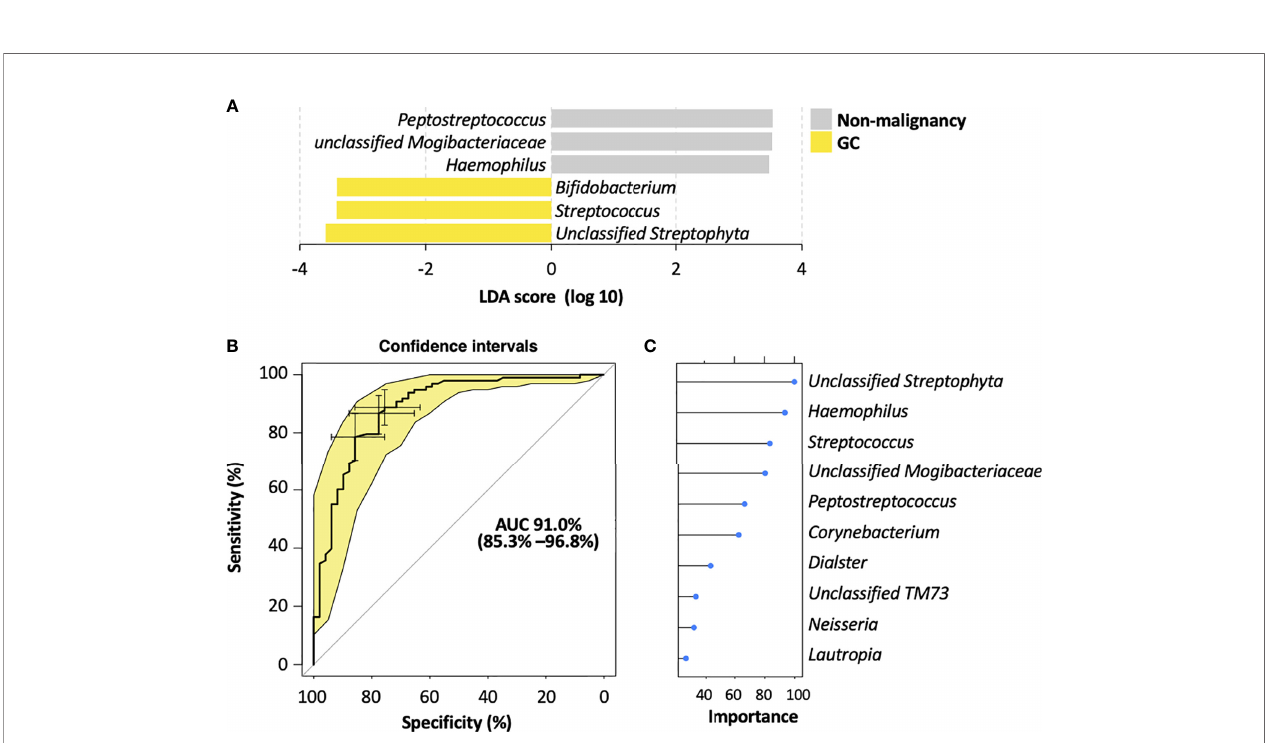
FIGURE 4 | Salivary bacterial biomarkers for classifying different stages of gastric carcinogenesis. (A) Microbiological features of the salivary microbiota associated with different histological stages of gastric tumorigenesis. Bacteria taxa that enriched in each histological stage were determined by LEfSe with Kruskal – Wallis test P < 0.05 and log 10 LDA score >3.4. (B) ROC curves analysis to evaluate the discriminatory potential of salivary bacteria in identifying GC out of pre-malignant lesions. (C) The top 10 bacterial genera that are most important for discriminating GC with non-malignant types. Each genus is ranked according to an importance score (mean decrease